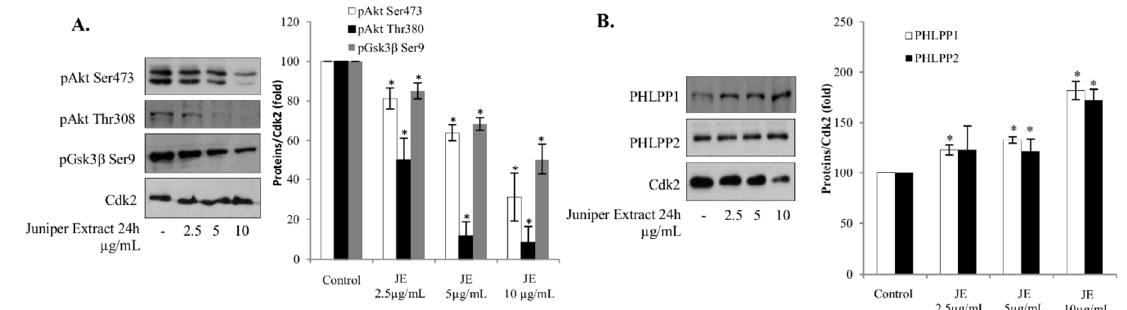
Figure 2. JE inhibited Akt signaling pathway in A549 cells. Serum-starved A549 cells were treated with JE for 24 h. ( A ) Cell lysates were analyzed for pAkt Ser473, pGSK3 β Ser9, and pAkt Thr308 by Western blotting. ( B ) Cell lysates were analyzed for PHLPP1 and PHLPP2 by Western blotting. ( A , B ) Cdk2 was used as loading control. Data are presented as bars ± standard deviation from three independent experiments. * Significantly different from control, p ≤ 0.05.